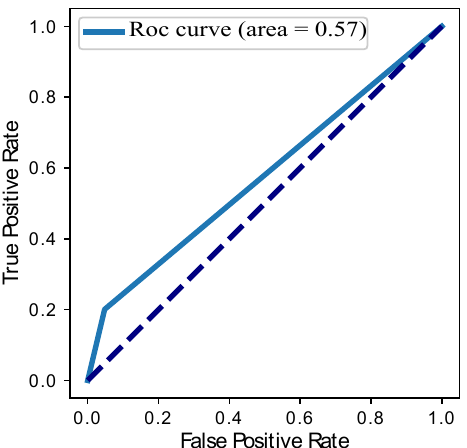
Figure 16. ROC curve of Support Vector Machine (SVM).